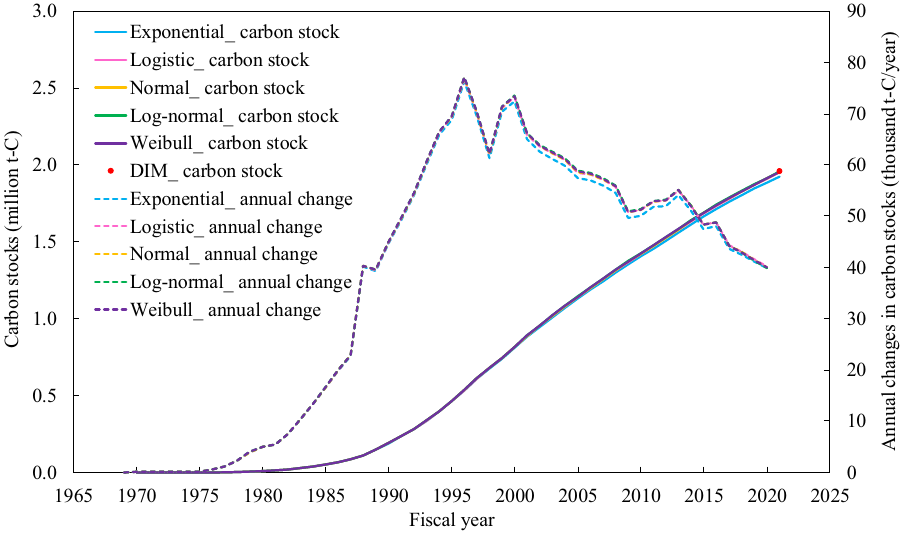
Figure 2. Estimated carbon stocks in wood products used in existing wooden houses. Note : “DIM” indicates the estimated results using the direct inventory method (DIM). Each lifetime function denotes the estimated results based on the parameters in Fig. 1 and Table 1 using the flux data method